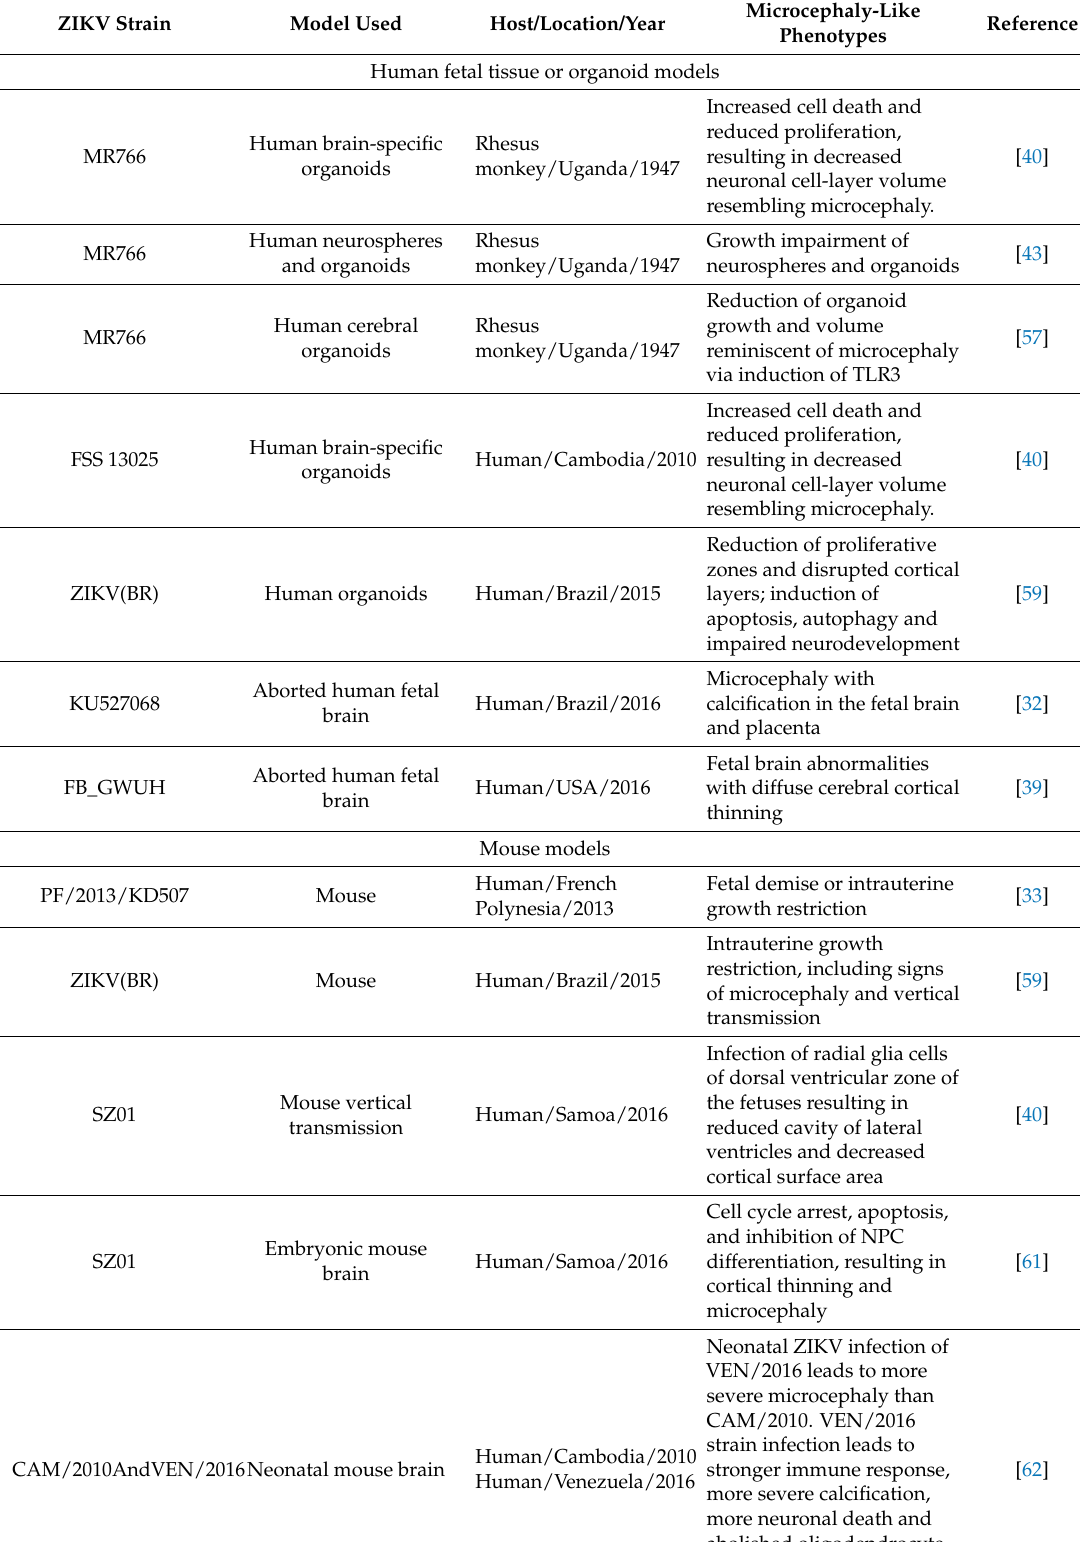
Table 1. Zika viral strains that are known to cause microcephaly or microcephaly-like phenotypes. ZIKV